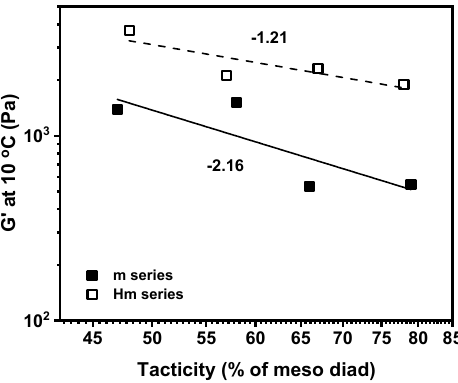
Figure 3. Comparison between G’ of m and Hm series at 10 °C (heating scan) as function of tacticity.